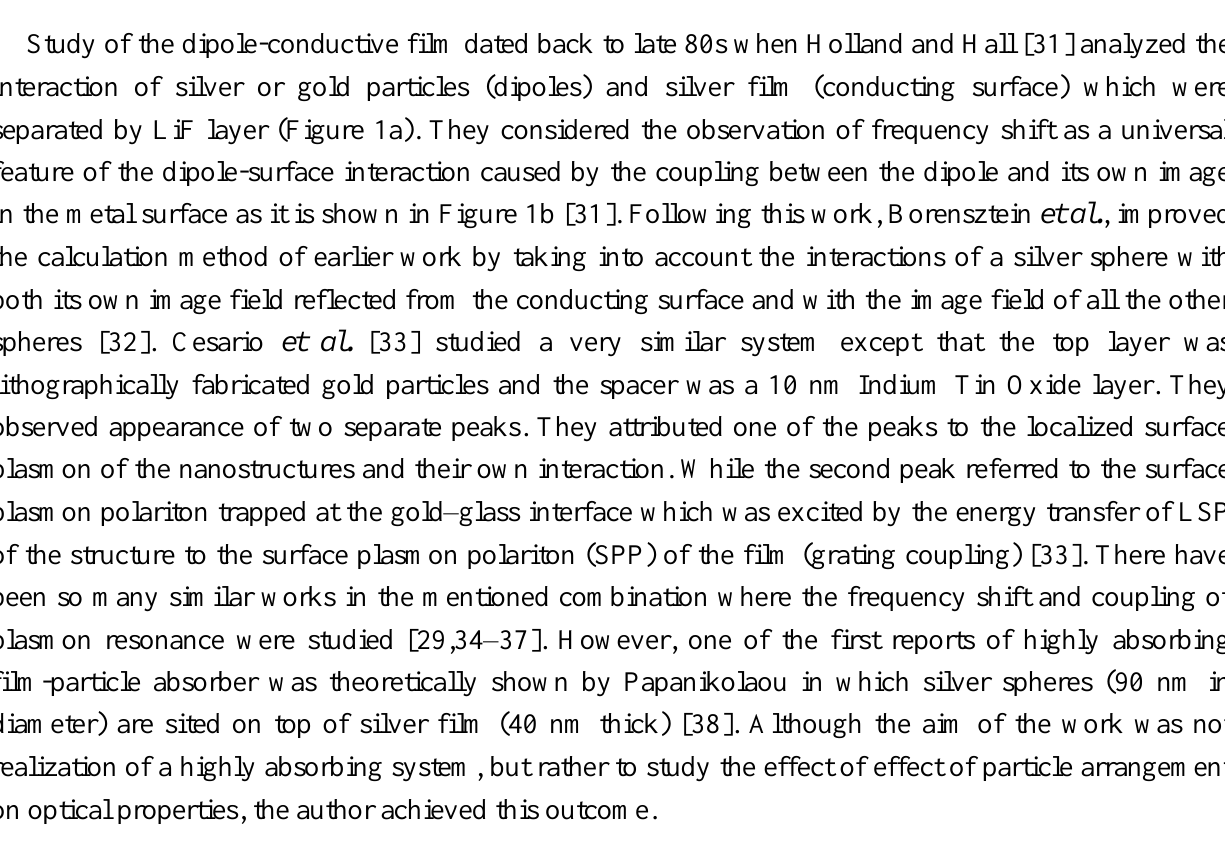
Figure 1. ( a ) Cross section of the three-layer sample geometry used in [31]; ( b ) Measured specular reflectance of silver-island samples R2 (normalized by Ag-LiF reflectance R1) as a function of wavelength for three different values of spacer-layer thickness d . The minima near 400 nm correspond to absorption by the silver islands. Curve a , d = 8 nm; curve b , d = 27 nm; curve c , d = 36 nm. (Reprinted with permission from [31]. Copyright 1982 American Physical